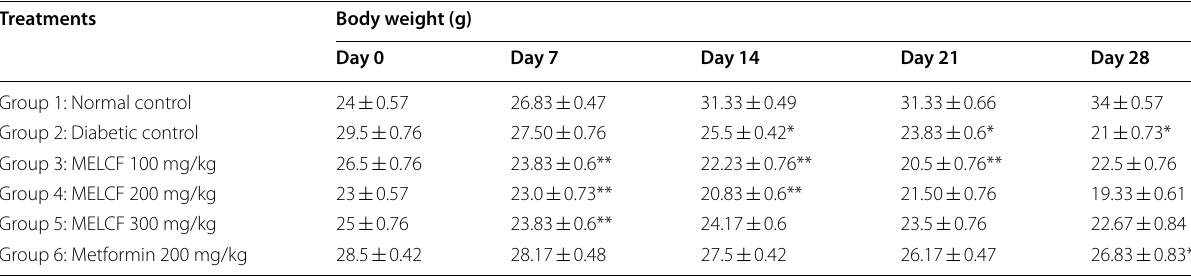
The values represented as mean (* p < 0.05) on same day